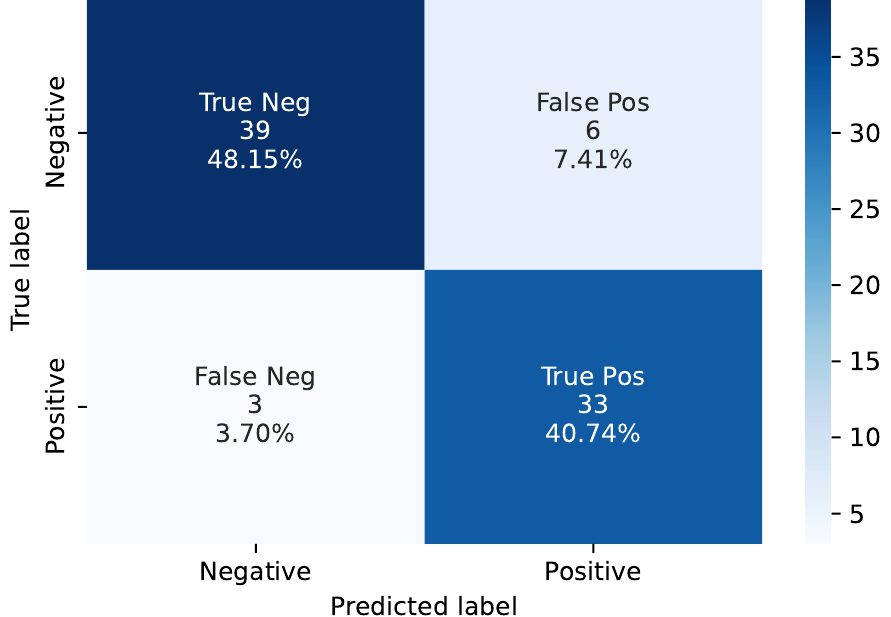
Figure 6. The confusion matrix of LWP on the test